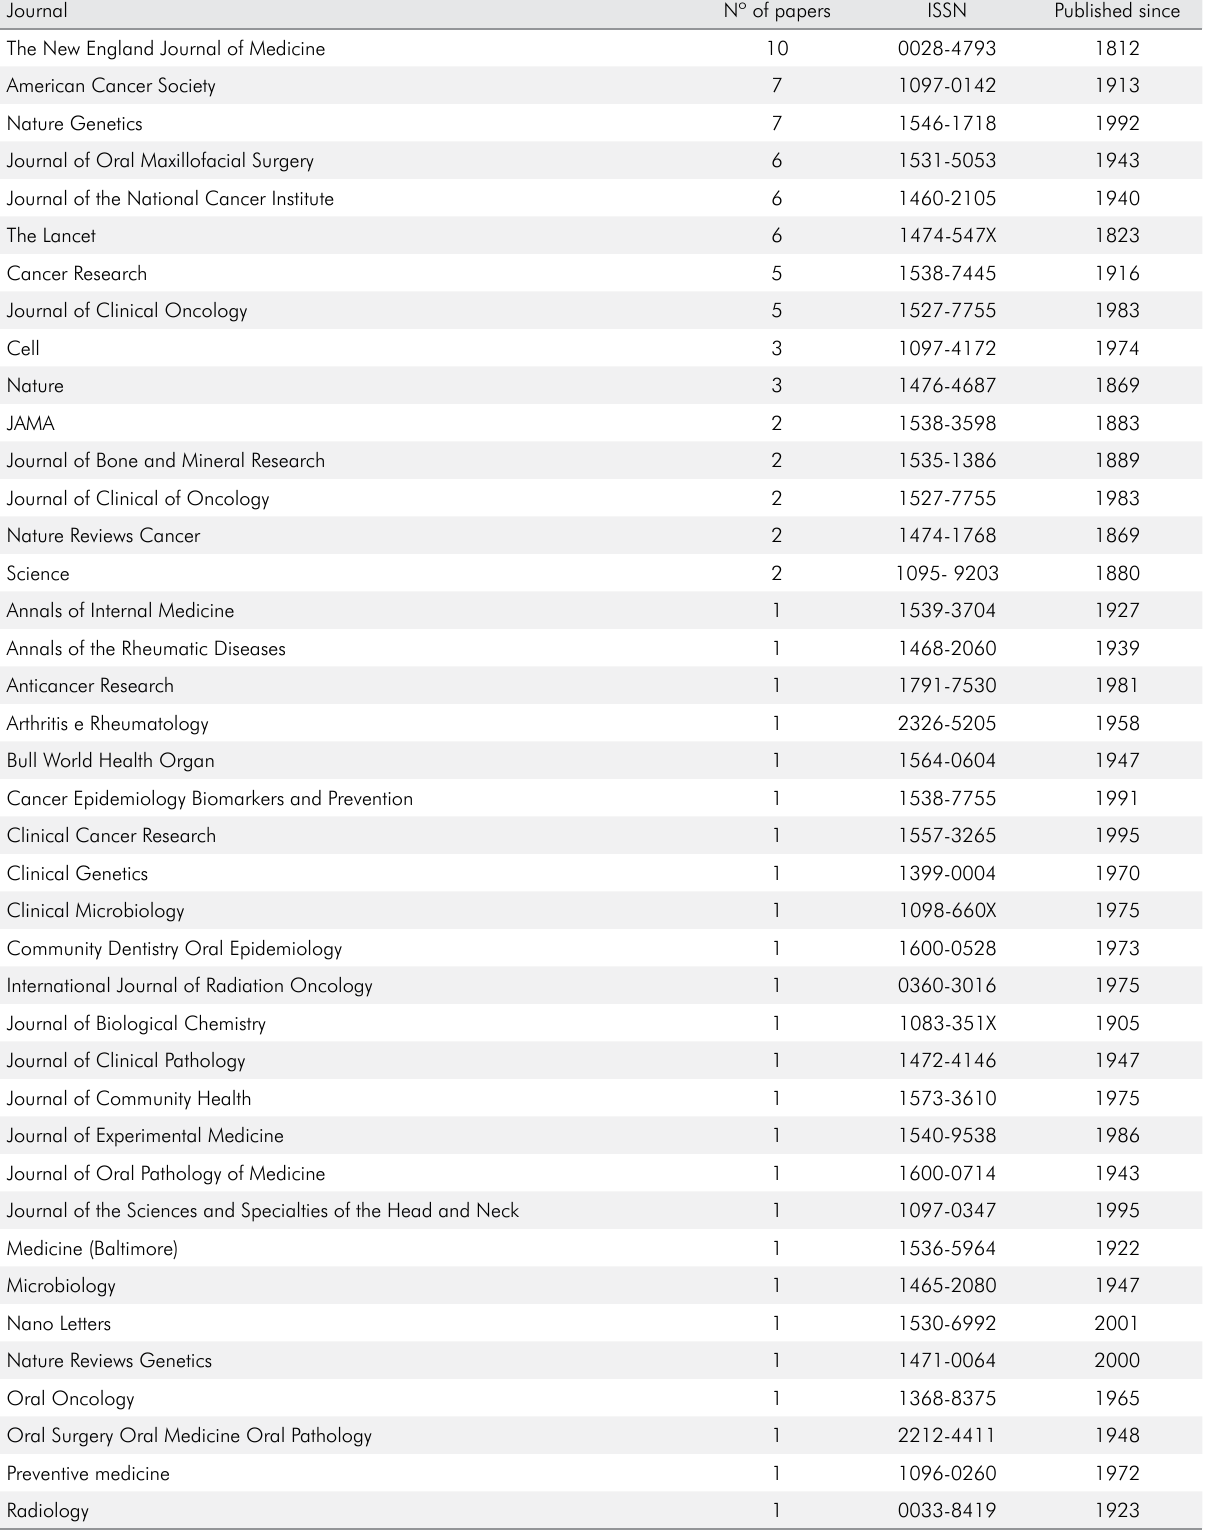
Table 2. The 47 journals in which the top-100 cited papers were